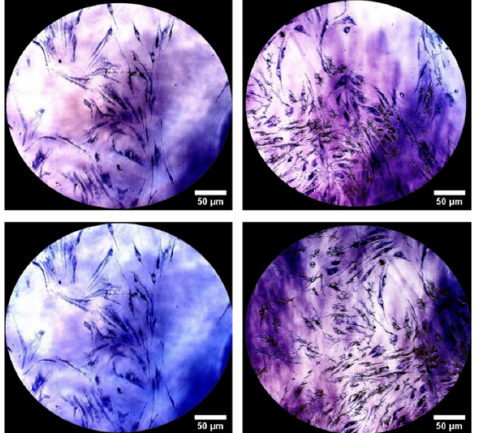
Figure 7. Representative images of NHDF cells in the hydrogel observed under optical microscope after 144 h of incubation. From left to right, magnification of 10×, 20× and 40×. To further confirm the biocompatibility of the hydrogel, after 144 h of incubation, 3 ‐ (4,5 ‐ dimethylthiazol ‐ 2 ‐ yl) ‐ 2,5 ‐ diphenyl tetrazolium bromide (MTT) staining was